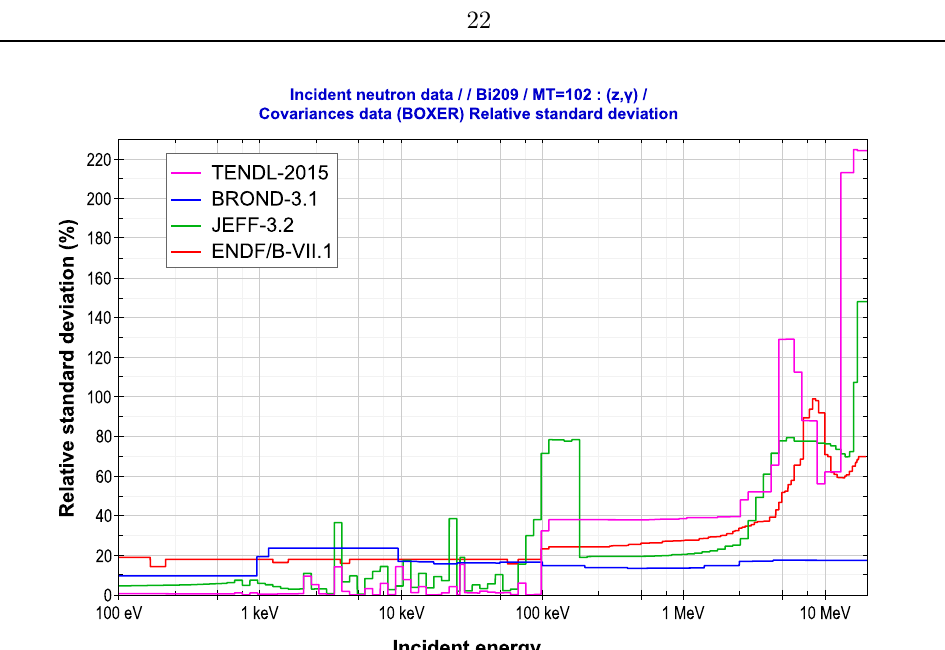
Fig. 5. Relative uncertainty of the 209 Bi cross section from different nuclear data libraries as a function of incident neutron